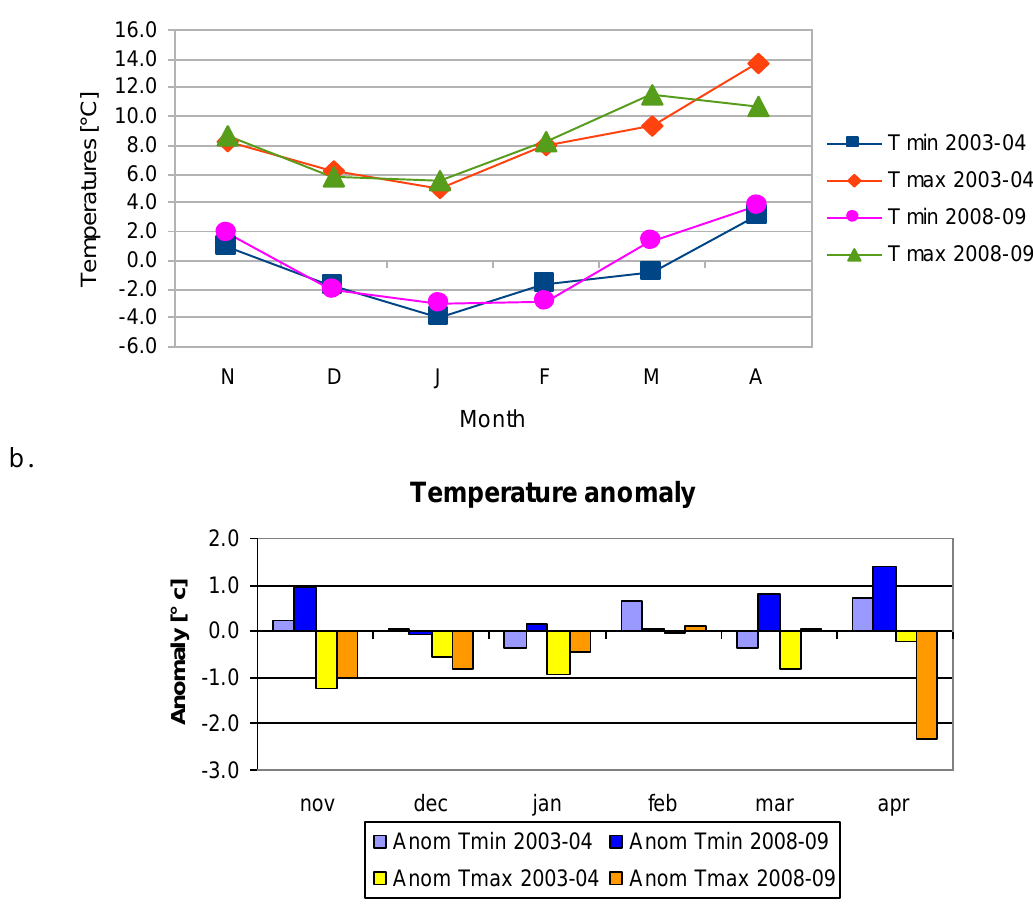
Figure 6. (a) Minimum and maximum temperatures recorded at Entracque Lago Piastra during the 2003–2004 and 2008–2009 snow seasons (November-April). (b) Minimum and maximum temperatures anomalies recorded at Entracque Lago Piastra during 2003–2004 and during 2008–2009 with respect to the 1971–2000 reference